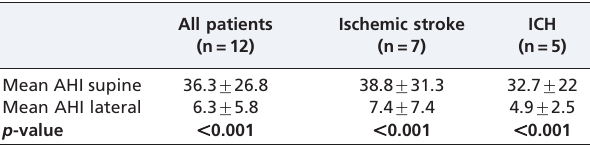
Table 3 - AHI in supine and lateral positions in patients with positional